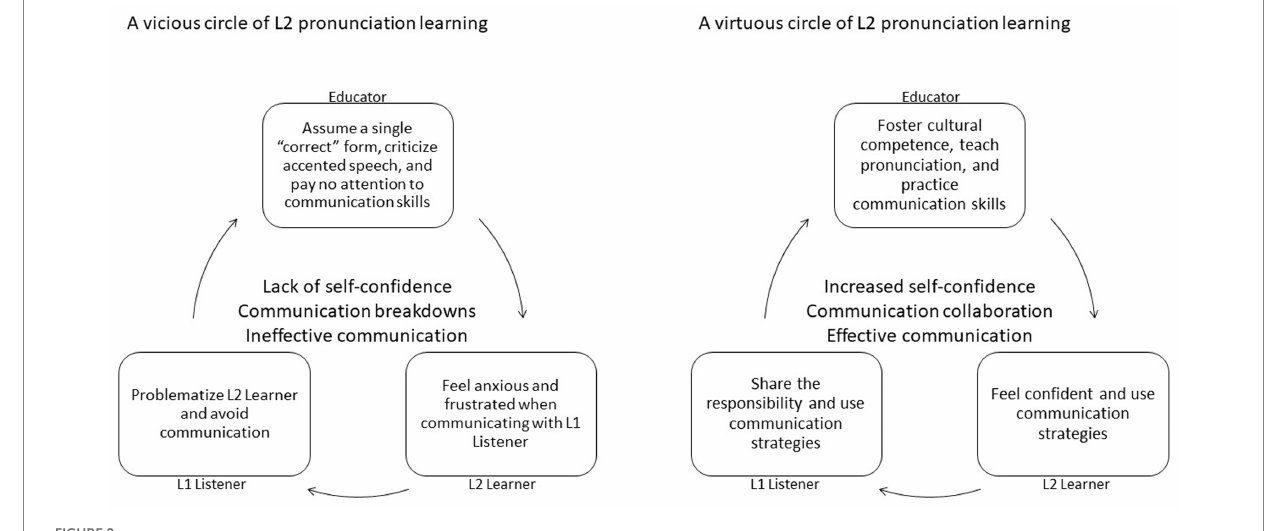
FIGURE 2 Attitudinal aspects of L2 speech in communication: vicious and virtuous